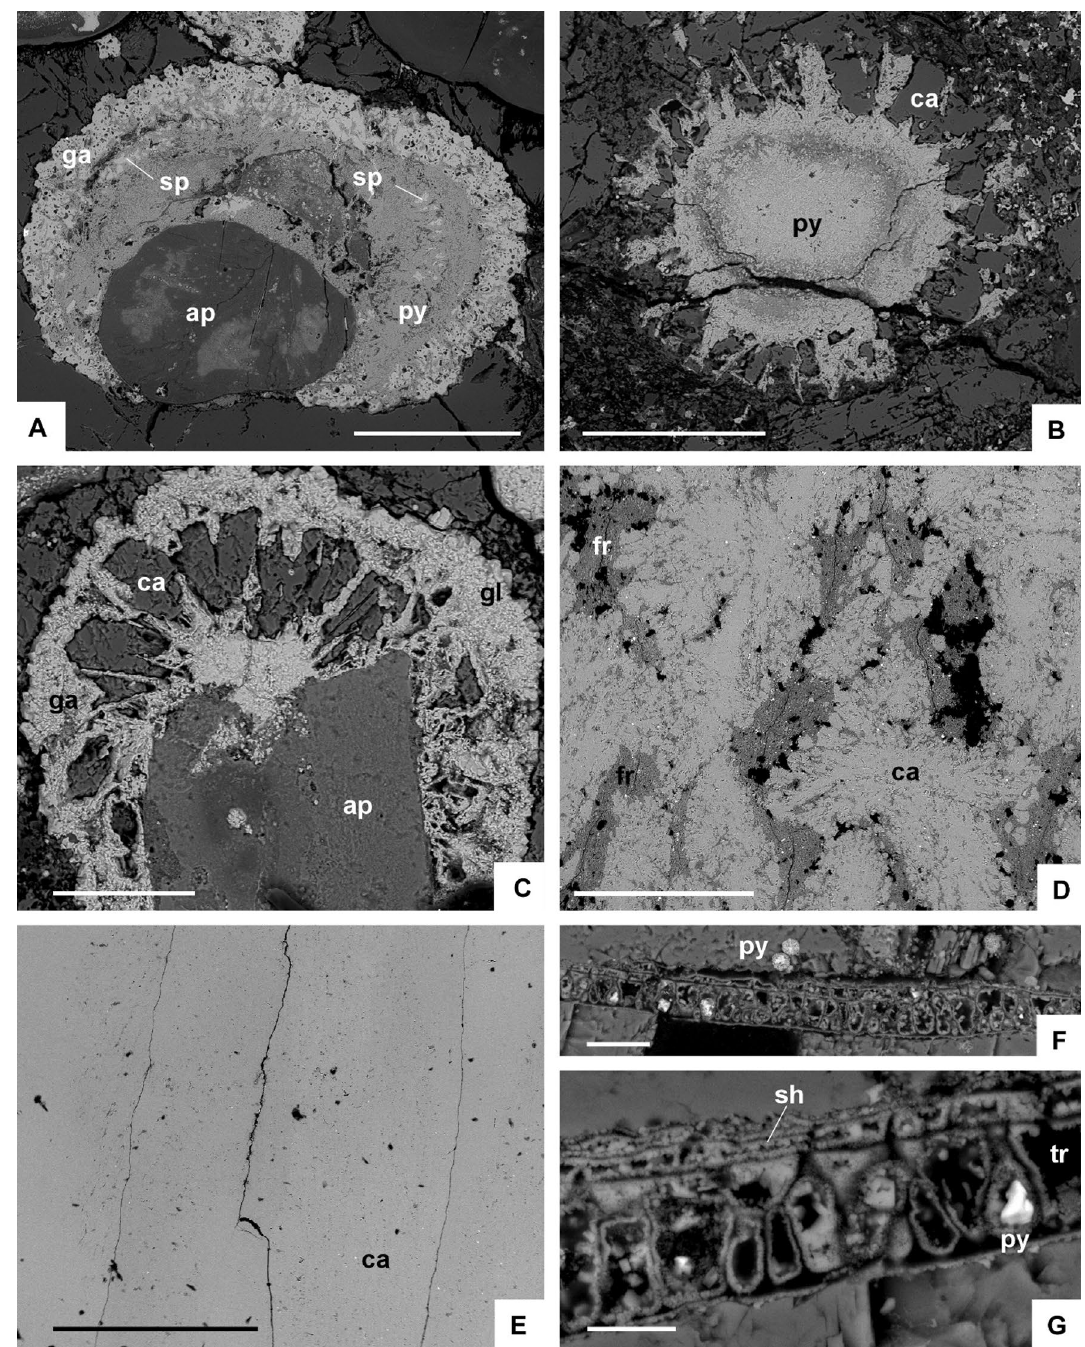
Figure 4. Scanning electron microscopy operating in back-scattered electron (SEM - BSE) photomicrographs. ( A) Polymetallic zoned crustiform band of pyrite including sphaleritic inclusions and growing over a clast of apatite; scale bar = 200 µm. ( B) Zoned pyrite encrusted by radiating pyrite/glendonite crusts; scale bar = 200 µm. ( C) Apatite clast encrusted by pyrite and radiating calcite/pyrite crusts; scale bar = 100 µm. ( D) Glendonitic feathery ca1 crystals arranged as stellate clusters (ca) separated by a clayey matrix rich in francolite (fr) crystals and strings; scale bar = 500 µm. ( E) Calcite pseudomorphs after anhydrite, encased in the phosphatic limestone of the Kakeled Limestone Bed; scale bar = 1 mm. ( F,G) Filamentous cyanobacteria, probably related to Oscillatoriopsis longa , with distinct preservation of trichome and sheath; pyrite occurs as framboids in ( F ) and as subhedral crystals infilling the primary porosity of the trichome in ( G ); scale bars = 20 and 10 µm, respectively. ap apatite, ca calcite (glendonite), py pyrite, sh sheath, sp sphalerite and tr